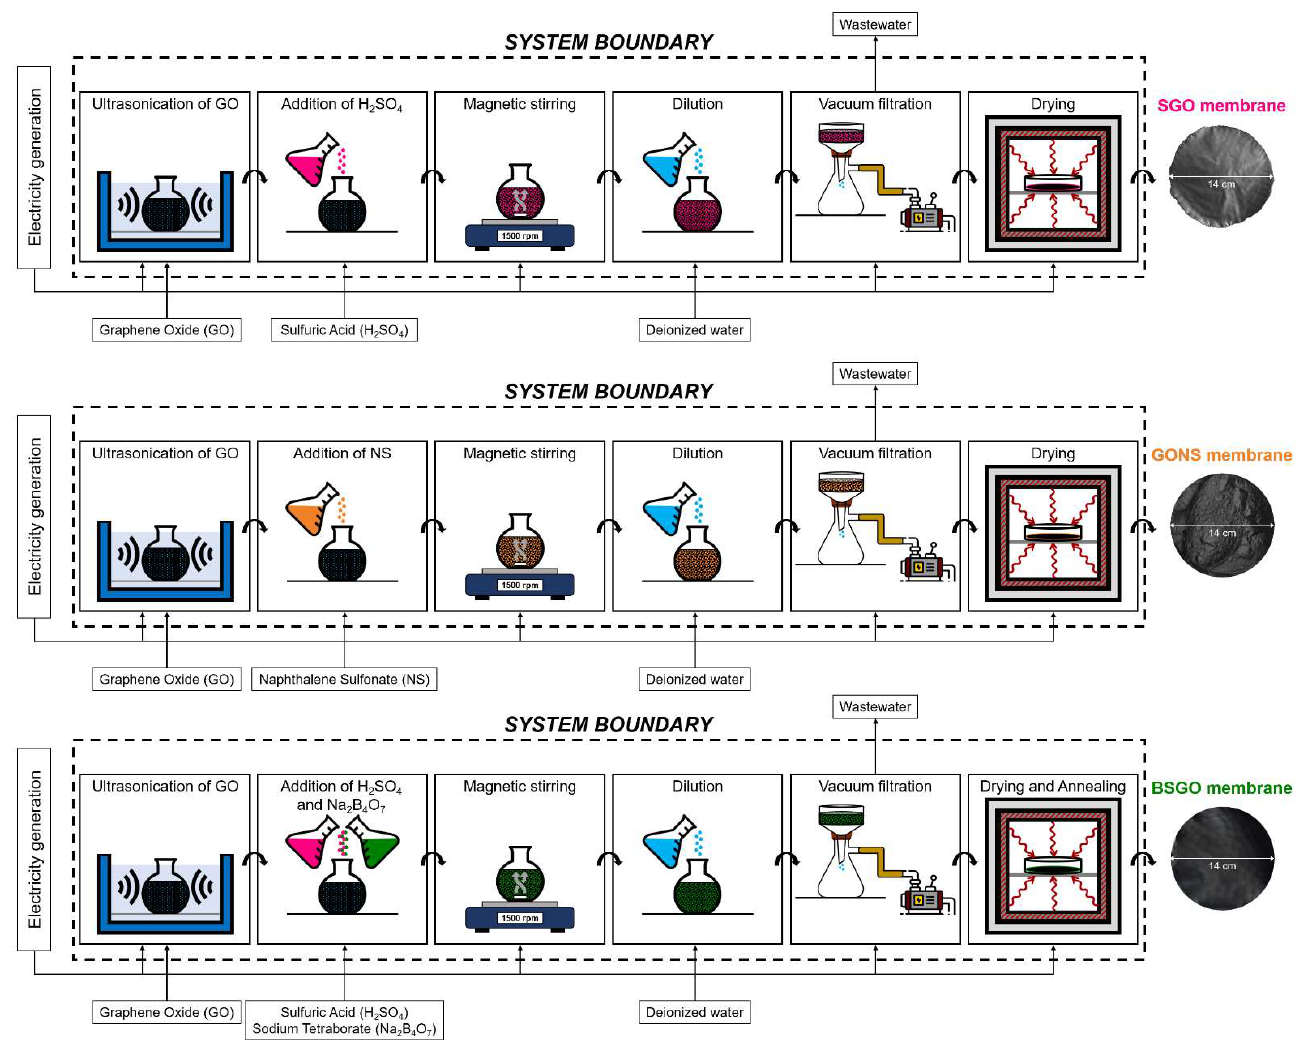
Figure 1. System boundaries of the laboratory fabrication procedures of SGO, GONS, and BSGO membranes with materials and energy input/output flows. Details about quantities and times of each step are described in Section 2.2.